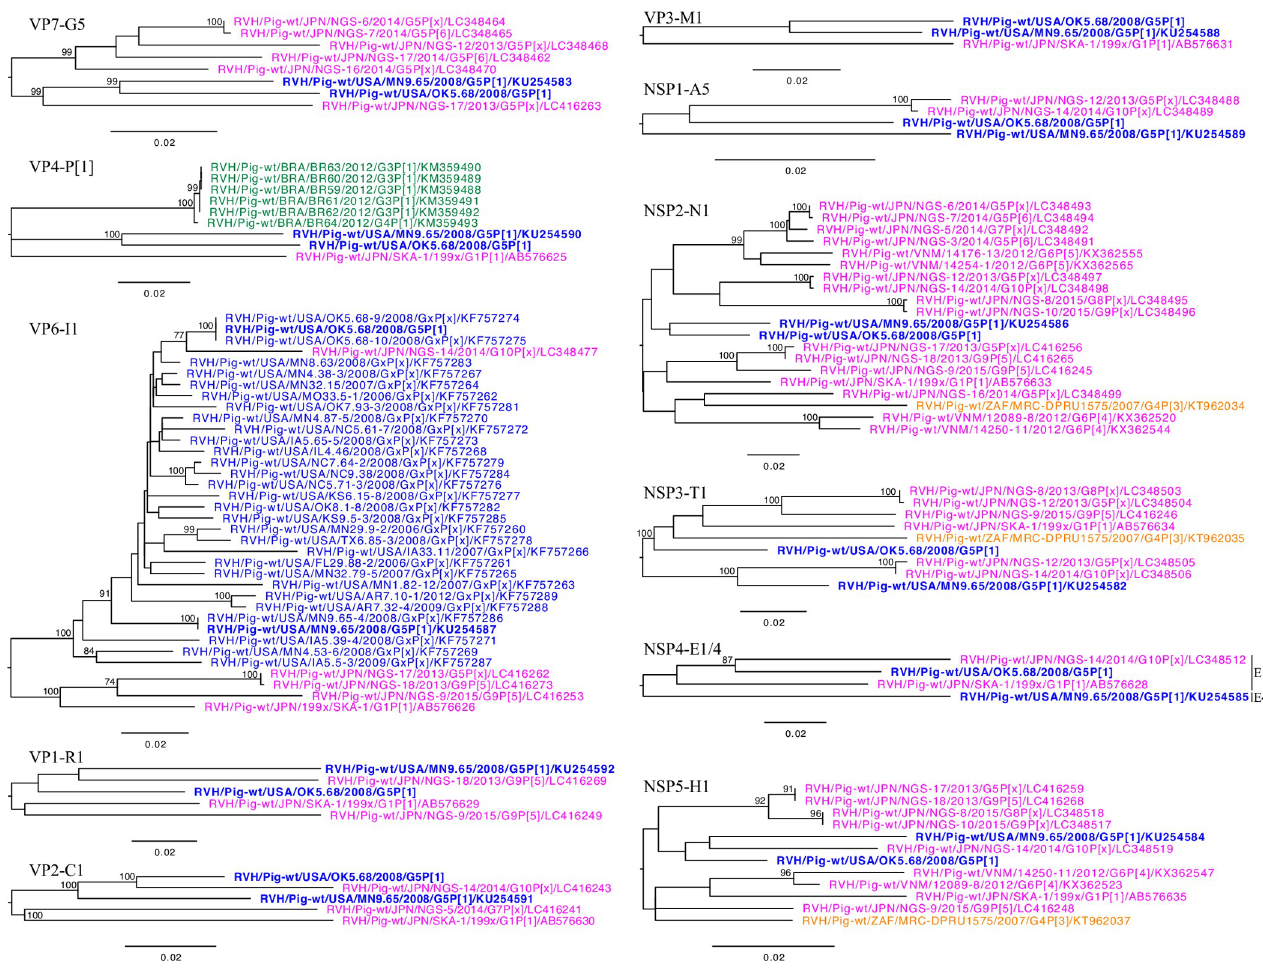
Fig 3. Phylogenetic trees of the RVH strains MN9.65 and OK5.68. The RVH strains from this study are represented in bold. The strains from Asia, North America, South America, and Africa are colored pink, blue, green, and orange respectively.